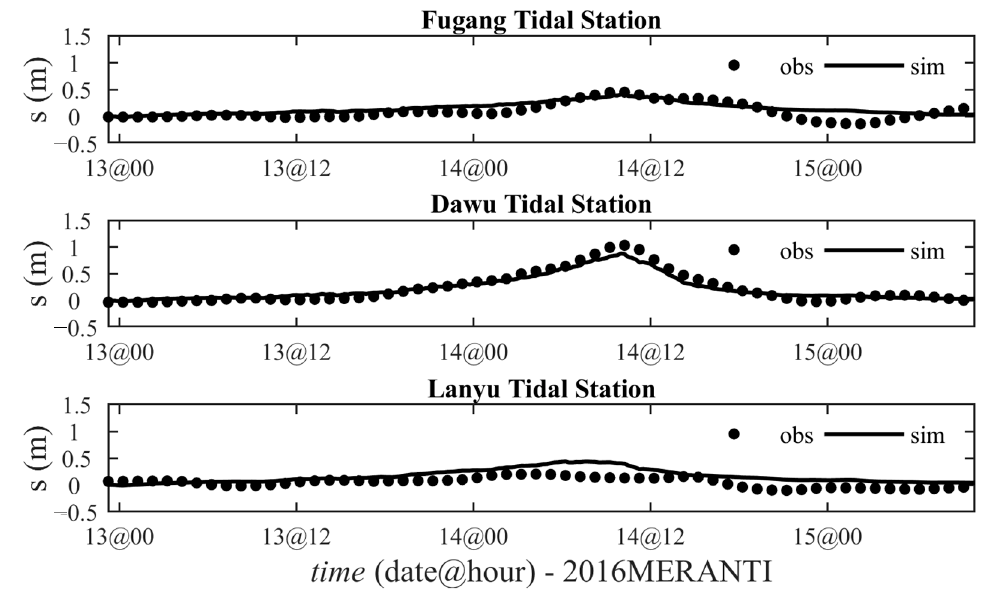
Figure 6. Comparisons of storm surges between model hindcasts and observations (Typhoon Meranti September 2017). Refer to Figure 5 for observation site locations.